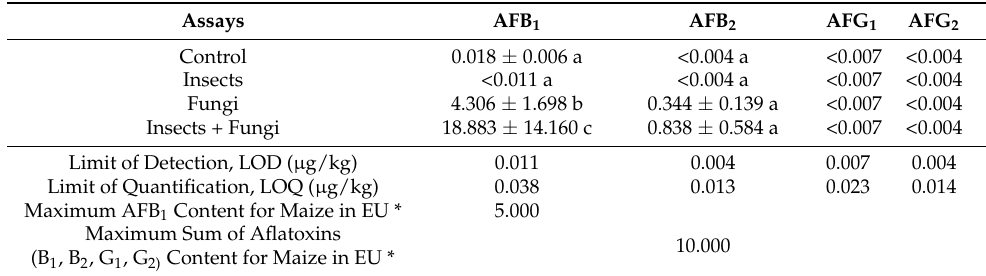
Table 2. The average contents ( µ g/kg) of aflatoxins (aflatoxin B1—AFB1; aflatoxin B2—AFB2; aflatoxin G1—AFG1; aflatoxin G2—AFG2) in the interaction assays: control (containing only maize flour, n = 2), insects (maize flour and Tribolium castaneum , n = 2), fungi (maize flour and Aspergillus flavus , n = 2) and insects and fungi (maize flour, T. castaneum and A. flavus , n = 3). Limits of detection (LOD) and quantification (LOQ) ( µ g/kg) are indicated for each aflatoxin analyzed. Different letters following the values of AFB1 and AFB2 in the same column indicate significantly different ( p < 0.05) values. Assays AFB 1 AFB 2 AFG